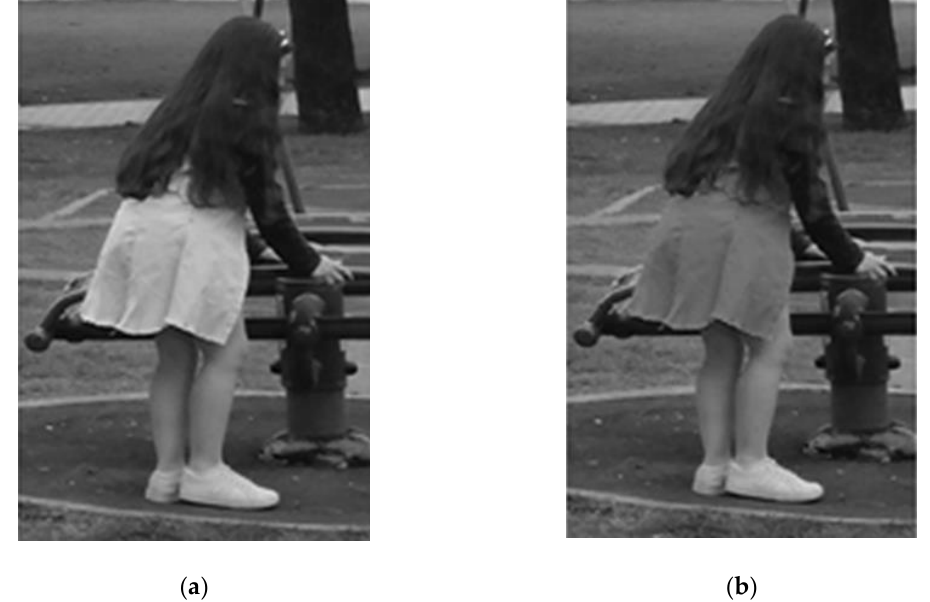
Figure 1. Example of manual colorization through Photoshop software: ( a ) original grayscale image; ( b ) colorized image corresponding to the girl’s dress. Source: CG-1050 dataset [5,6].